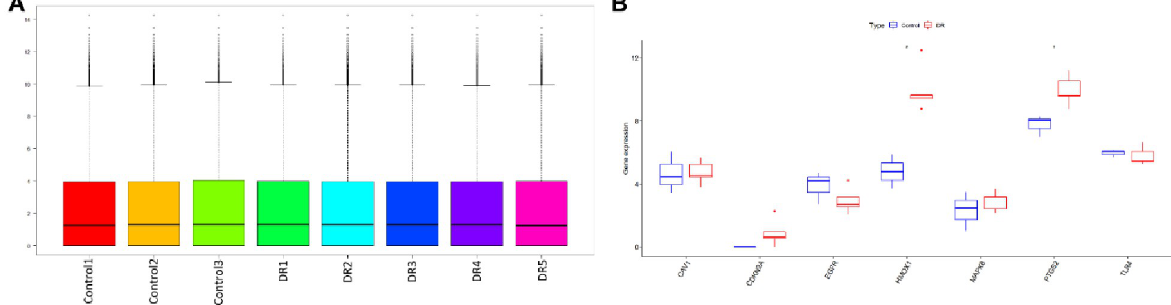
Fig 7. Gene expression of samples. (A) The values of each group centered on the median. (B) Expression of hub genes in each group. � p < 0.05.